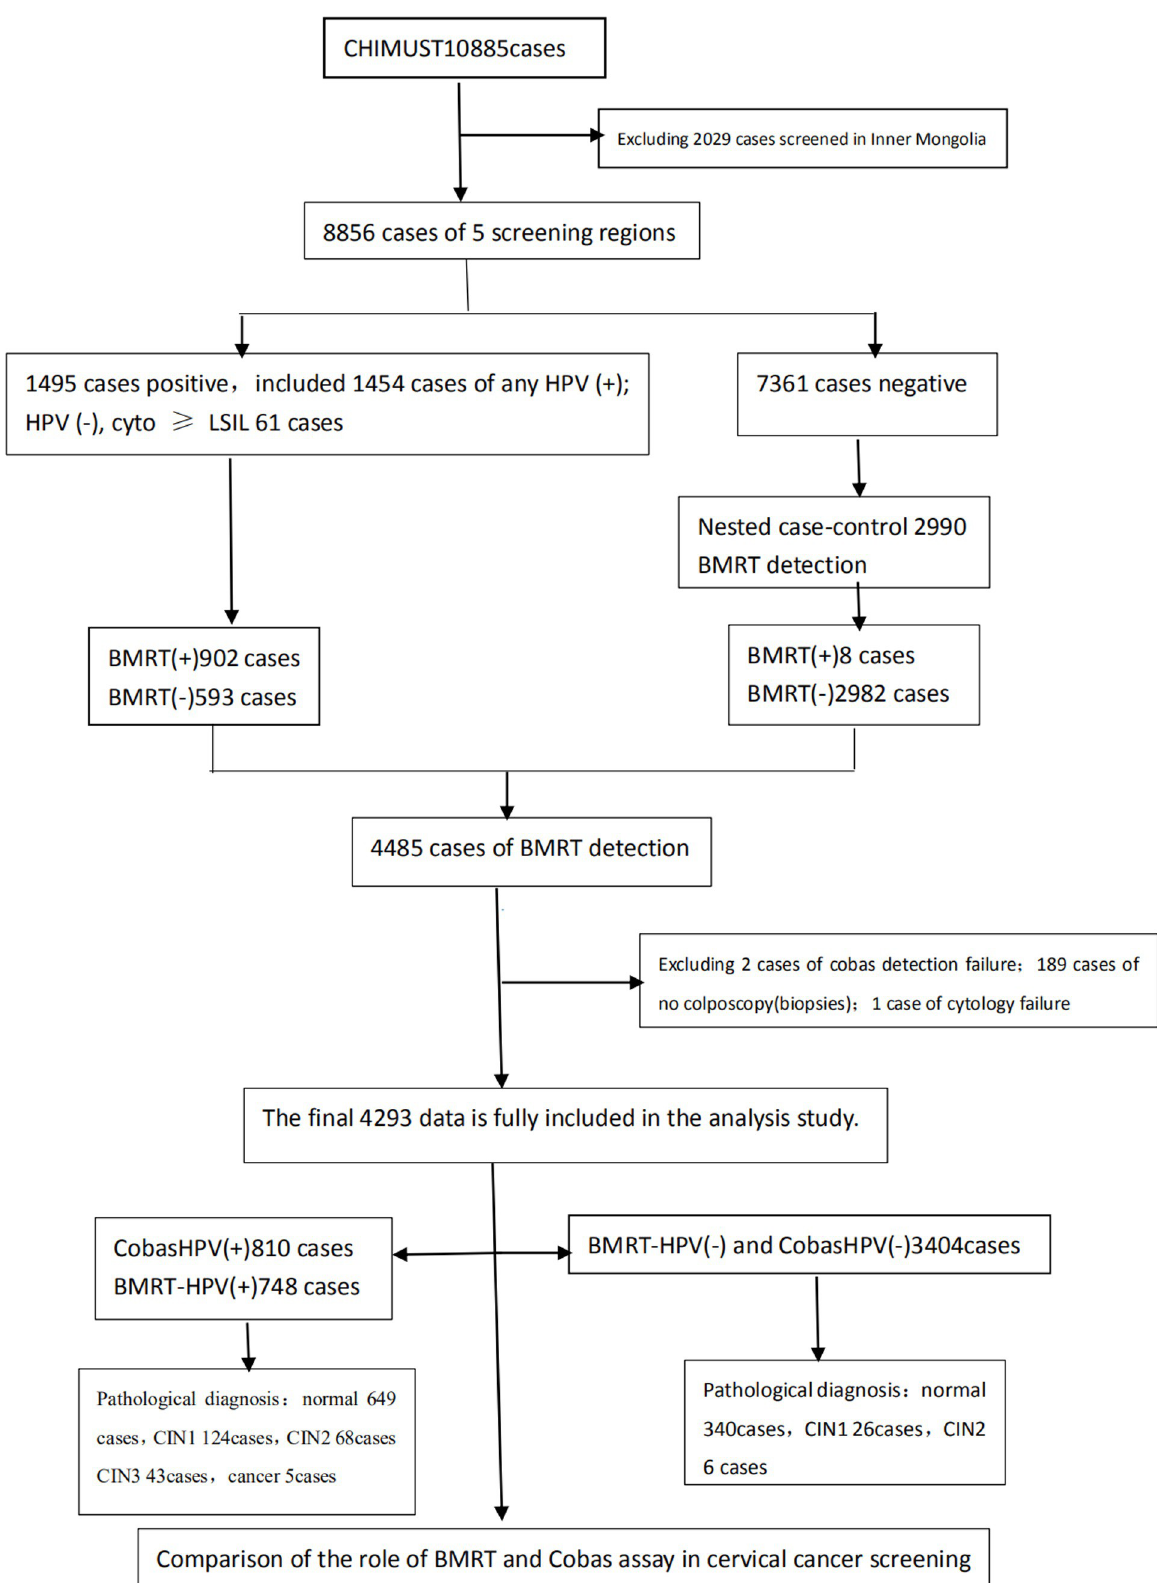
Fig 1. BMRT-HPV nested case–control study population.